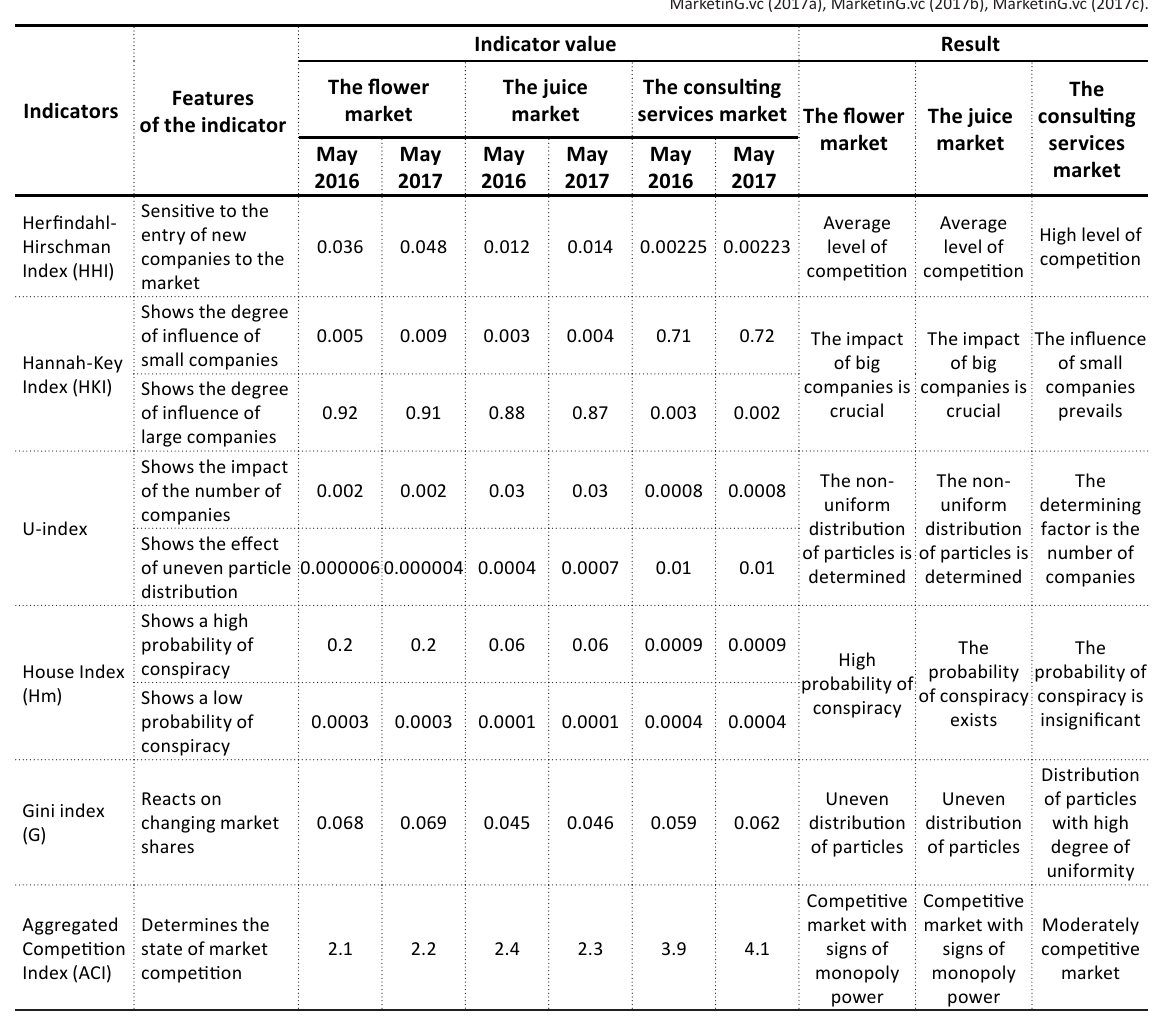
Table 3. Indicators of the level of development of competition for markets of various types of